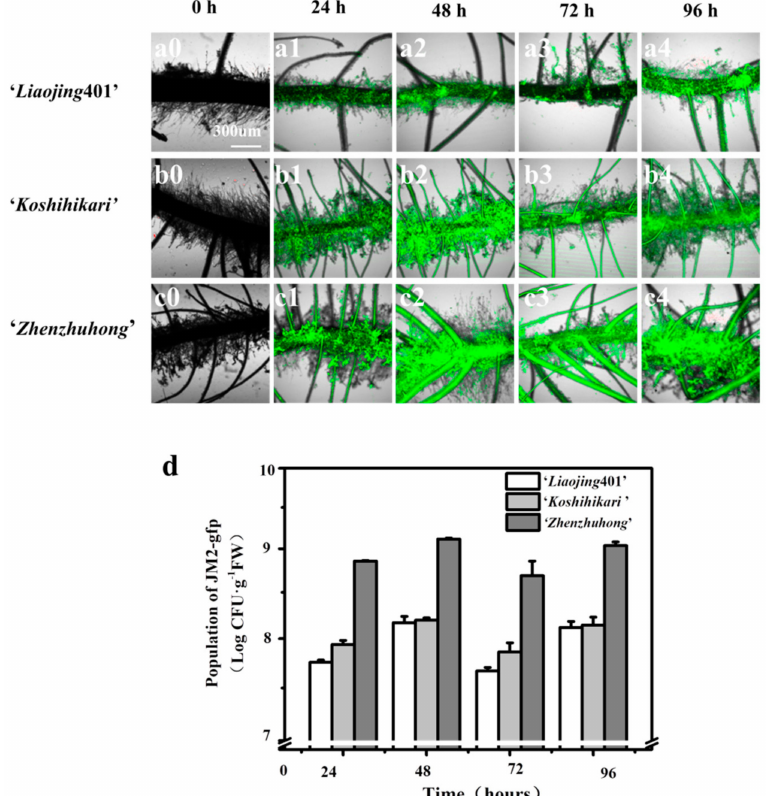
Figure 3. Biofilm formation by JM2-gfp on the root surfaces of ‘ Liaojing 401’ ( a0 , a1 , a2 , a3 , a4 ), ‘ Koshihikari ’ ( b0 , b1 , b2 , b3 , b4 ), ‘ Zhenzhuhong ’ ( c0 , c1 , c2 , c3 , c4 ) within 96h observed using CLSM and plate counting ( d ). The images shown were produced from overlays of fluorescence (false-colored green) and transmitted light (gray)